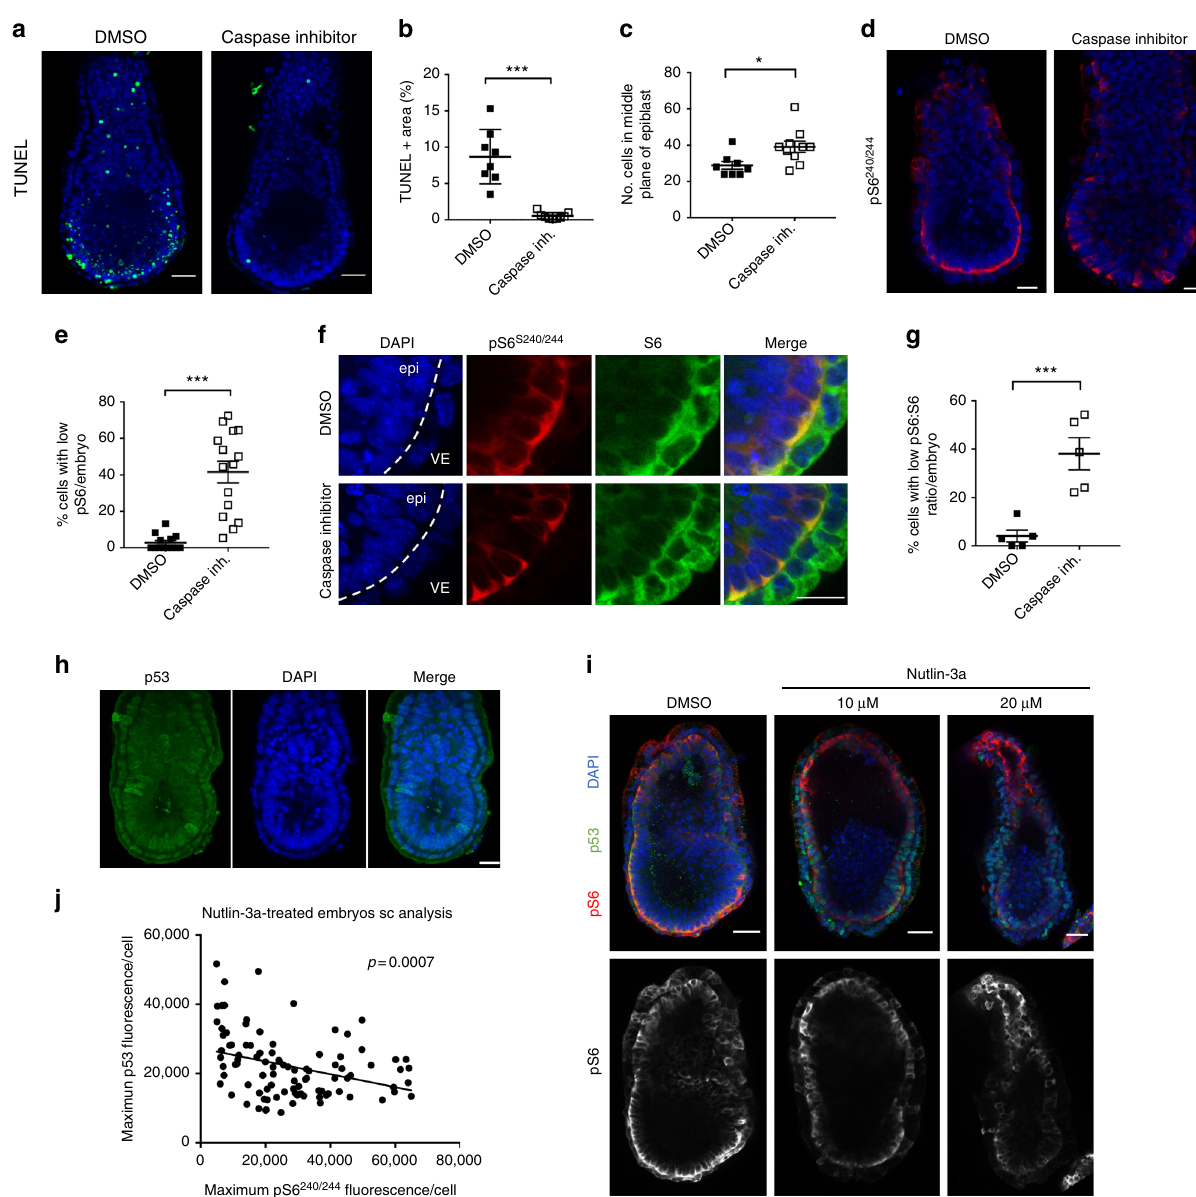
Fig. 6 Evidence for a role of p53 and mTOR signalling during physiological competition during embryogenesis. a , b Wild-type embryos were cultured in DMSO or 200 uM pan-caspase inhibitor for 16 – 18 h and cell death was assessed by TUNEL staining. c Wild-type embryos were cultured in DMSO or caspase inhibitors and number of cells in the medial plane of the epiblast was quanti fi ed; caspase inhibition results in a 35% increase in the average number of cells counted in the medial plane of the epiblast (DMSO n = 8, average 28.9 cells; caspase inhibitor n = 10, average 39.1 cells). d Wild-type embryos cultured overnight in DMSO or caspase inhibitors were stained for pS6 S240/244 . e In each embryo, the percentage of cells below a ‘ low pS6 cutoff ’ in the medial plane of the epiblast was quanti fi ed (as shown in Supplementary Fig. 8A): percentage of low pS6 cells increases from 2.8% in DMSO treated embryos to 41.5% in caspase-inhibitor-treated embryos. Data are collated from three litters (DMSO n = 13; caspase inhibitor n = 15). f Magni fi cation of DMSO- or caspase inhibitor-treated embryos stained for pS6 and total S6. The boundary between the visceral endoderm (VE) and epiblast (epi) is indicated with a dashed line. g In each embryo, the percentage of cells below a ‘ low pS6:S6 ’ cutoff (as shown in Supplementary Fig. 8B) was quanti fi ed: percentage of low pS6:S6 cells per embryo increases from 4% in DMSO-treated embryos to 38% in caspase-inhibitor-treated embryos. Data are collated from one litter (DMSO n = 5; caspase inhibitor n = 5). h p53 expression in 5.5 dpc embryos detected by immuno fl uorescence. i Embryos were treated with DMSO or Nutlin-3a for 6 h and levels of p53 and pS6 were analysed by immuno fl uorescence and the correlation between p53 and pS6 levels were quanti fi ed at the single-cell level ( j ). Scale bars are 40 μ m ( a , i ), 25 μ m ( b ) or 20 μ m ( f , h ). Error bars denote SD ( b , c ) or SEM ( e , g ). ** p < 0.01, *** p < 0.005; unpaired, two-tailed t